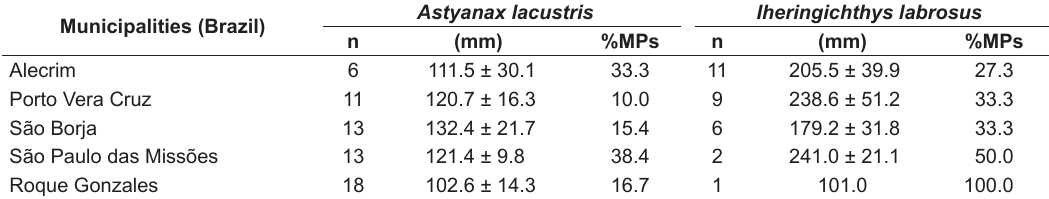
Table 1. The number of individuals (n), standard length (mm), and percentage of individuals with microplastics (MPs) of both analyzed species in Uruguay River,